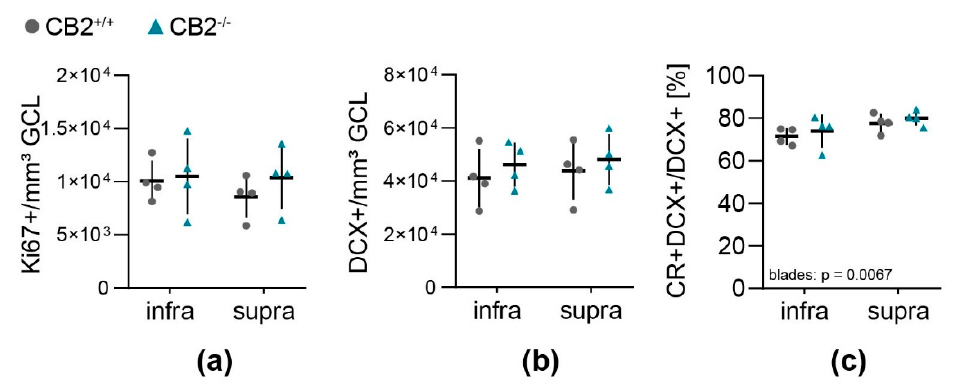
Figure 2. Quantification of neural progenitor cell populations and proliferation in the dentate gyrus of wildtype and CB2-deficient mice. The number of cells positive for Ki67 ( a ) and DCX ( b ) per sample volume (GCL and SGZ) in the infra- and suprapyramidal blade of the dentate gyrus in CB2 +/+ (circle) and CB2 − / − (triangle). ( c ) Percentage of post-mitotic DCX +/ CR + immature neurons from total amount of DCX + cells in the infra- and suprapyramidal blade of the dentate gyrus in both genotypes. Each n represents one animal. CB2 +/+ , n = 4, CB2 − / − , n = 4. Mean ± SD. Table 1. Mean ± SD values of Ki67+ and DCX+ cells per mm 3 of the granular cell layer and percentage of immature neurons (CR+DCX+) from all DCX+ positive cells in wildtype (CB2 +/+ ) and CB2-deficient (CB2 − / − ) mice and in both blades of the dentate gyrus. inf.—infrapyramidal, sup.—suprapyramidal. Ki67+ per mm³ DCX+ per mm³ CR+DCX+/DCX+ [%] Genotype inf. sup. both inf. sup. both inf. sup. both